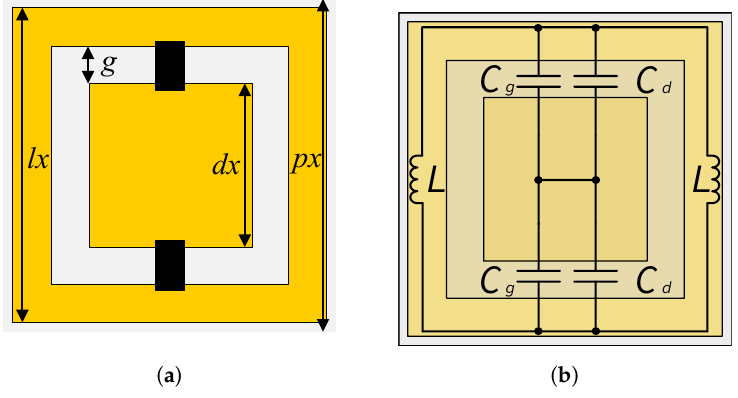
Figure 2. ( a ) Stacked unit-cell and ( b ) equivalent circuit.